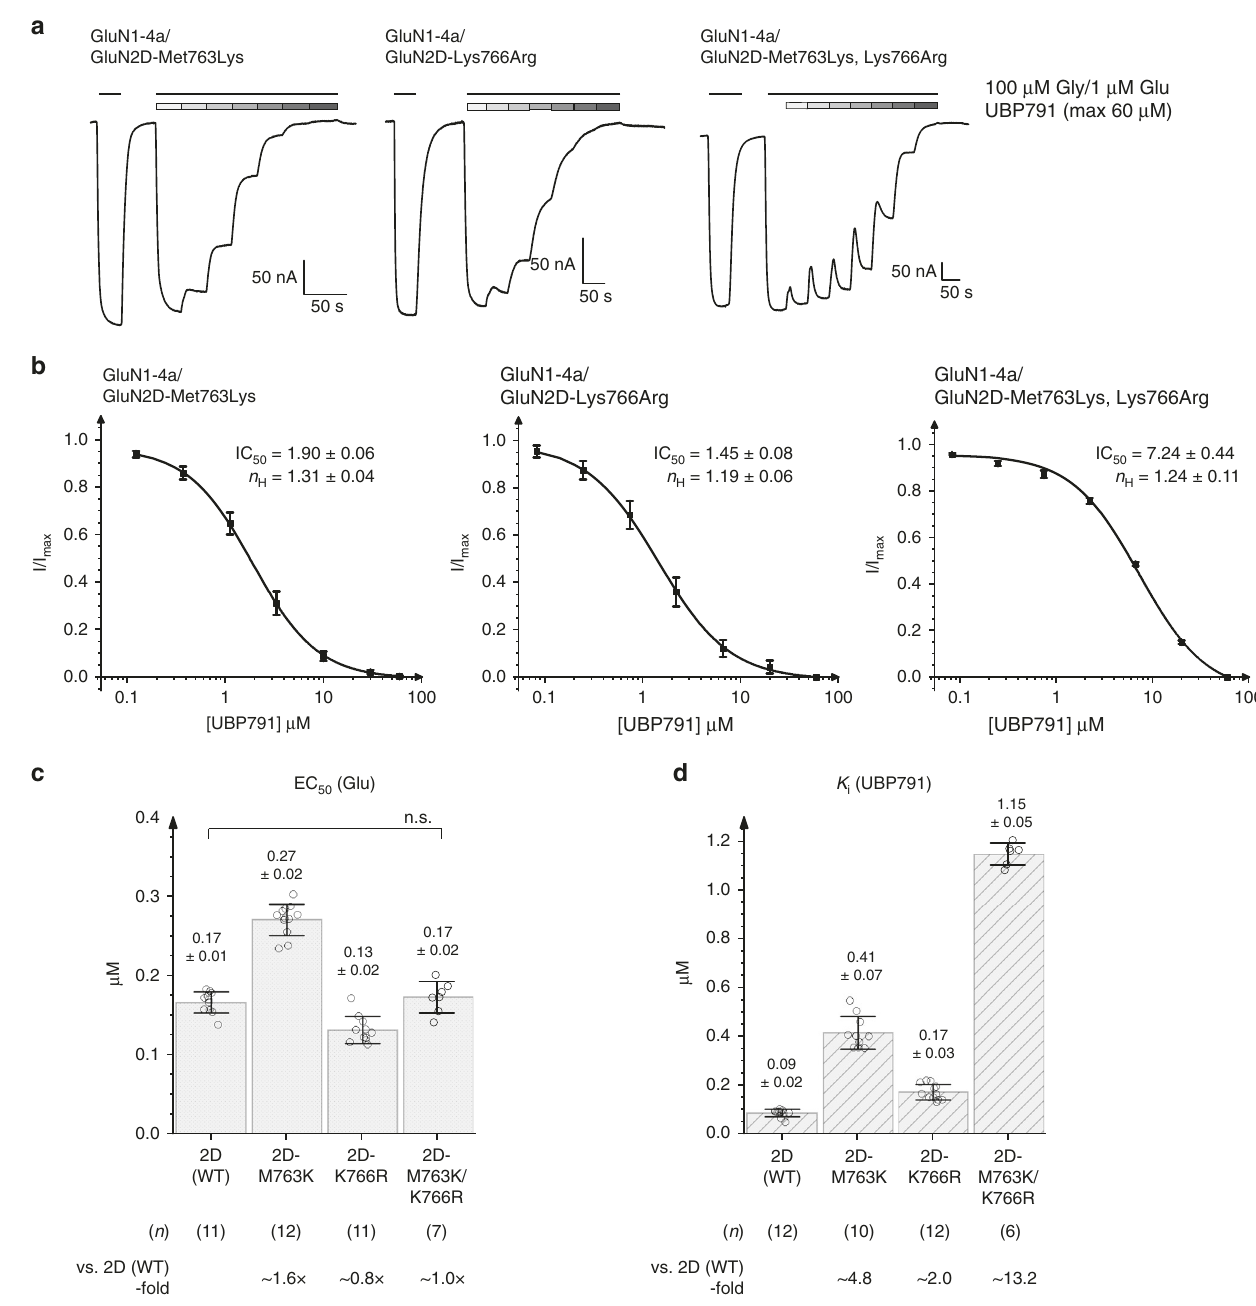
Fig. 6 Effect of mutations in GluN2D on L -glutamate and UBP791 sensitivity. a Representative TEVC dose-response traces of single mutant GluN1-4a/ GluN2D Met763Lys (left panel), Lys766Arg (middle panel) or double mutant Met763Lys/Lys766Arg (right panel) NMDARs held at − 60 mV. Currents were evoked by application of 100 μ M glycine and 1 μ M L -glutamate and inhibited by varying concentrations of UBP791 (Met763Lys: concentration increments: 0.12/0.37/1.1/3.3/10/30/60 μ M; for Lys766Arg and double mutant: three-fold increments from 0.08 – 60 μ M). b Averaged dose-response curves (mean ± s.d.) for inhibition with UBP791 from eight, twelve, and six recordings for GluN1-4a/GluN2D Met763Lys, GluN1-4a/GluN2D Lys766Arg, and GluN1-4a/GluN2D Met763Lys/Lys766Arg, respectively, fi t with the Hill equation to calculate IC 50 and Hill coef fi cient ( n H ). c EC 50 for L -glutamate and d K i for UBP791 for the mutants were obtained by TEVC recordings as in Fig. 2. Single data points are shown as open circles, the bar graph represents the mean with error bars for s.d., the number of recordings (n) and the fold-difference to EC 50 and K i of GluN2D (WT) are as shown. Pairwise comparison shows WT and mutants have different potencies ( p < 0.05 with two-tail t-test and Bonferroni correction) except where stated (Supplementary Fig. 6). Hence, insensitivity of PPDA, UBP791 GluN2 LBD structures with the antagonist-bound GluA2 LBD and UBP1700 on AMPAR is likely due to steric clashes with (PDB: 1FTL) 44 or GluK1 LBD (4YMB) 45 reveal potential steric piperazine/phenanthrene moieties, while increased insensitivity of clashes between the PPDA-backbone moiety and the residues UBP791 and UBP1700 on kainate receptors can likely be attributed GluA2-Glu726/Met729 (GluA1-Glu719/Met722) and GluK1- to charge repulsion resulting from the additional carboxyethyl or Glu753 (GluK2-Glu738), as well as charge repulsion between the carboxyvinyl group. carboxyethyl group of UBP791 and GluK1-Glu457 (GluK2-Glu441)